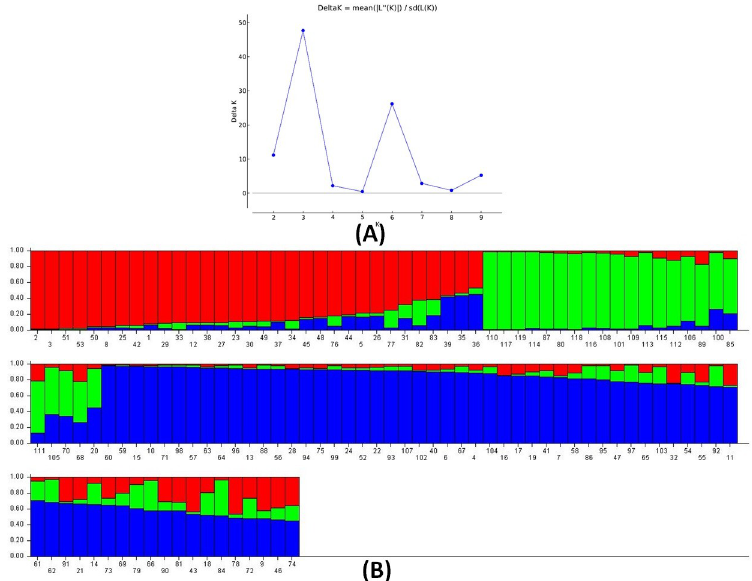
Fig 3. (A) Graph generated by ploting delta K vs. K for determination of peak value and (B) the genetic structure groups obtained for the studied panel population and sorted as per the group. The numbers in the figure denotes the genotypes serial number as enlisted in Table